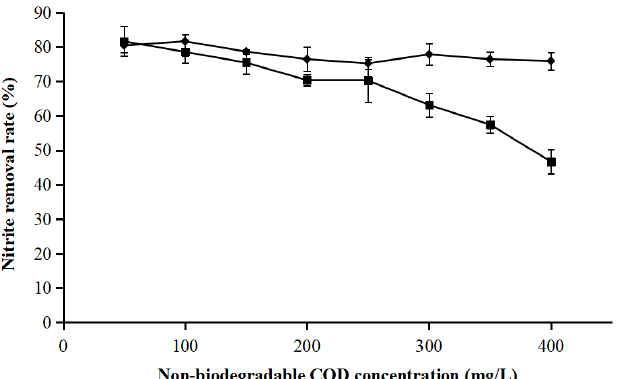
Figure 8. Influence of non-biodegradable organic matter on ANAMMOX activity ( ♦ : nitrite removal rate after 1 day; ■ : nitrite removal rate after 5 days).